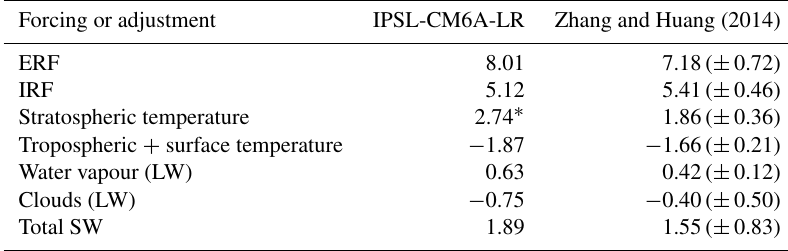
∗ Starred values are outside the 2 σ range from Zhang and Huang